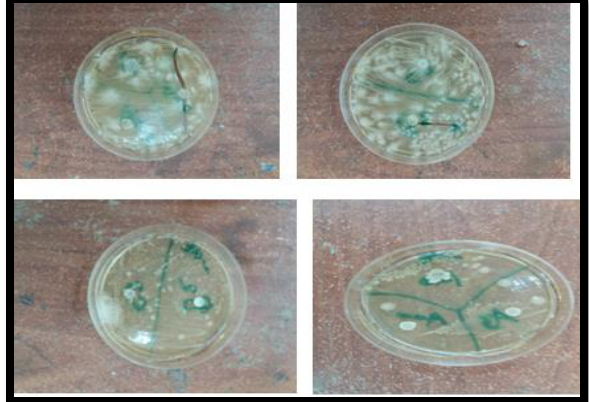
Figure, 1: Shows zone of bacterial